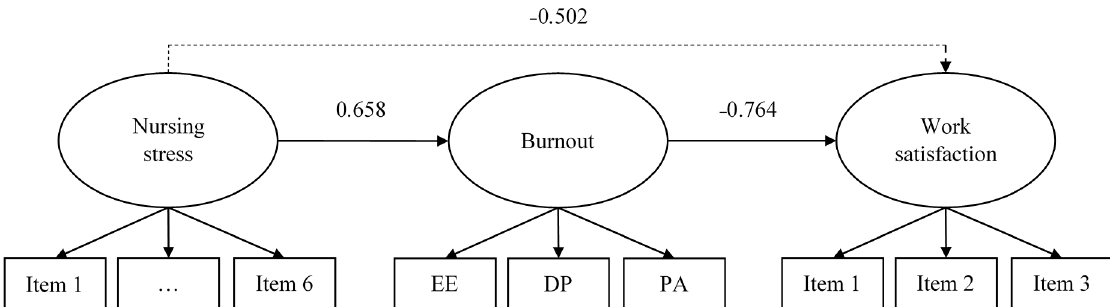
Figure 1. Structural equation modeling predicting burnout and work satisfaction. Notes: EE = Emotional exhaustion; DP = Depersonalization; PA = Personal acceptance. All the factor loadings, direct effects and the indirect effect were statistically significant ( p < 0.001). Script line represents the indirect effect.